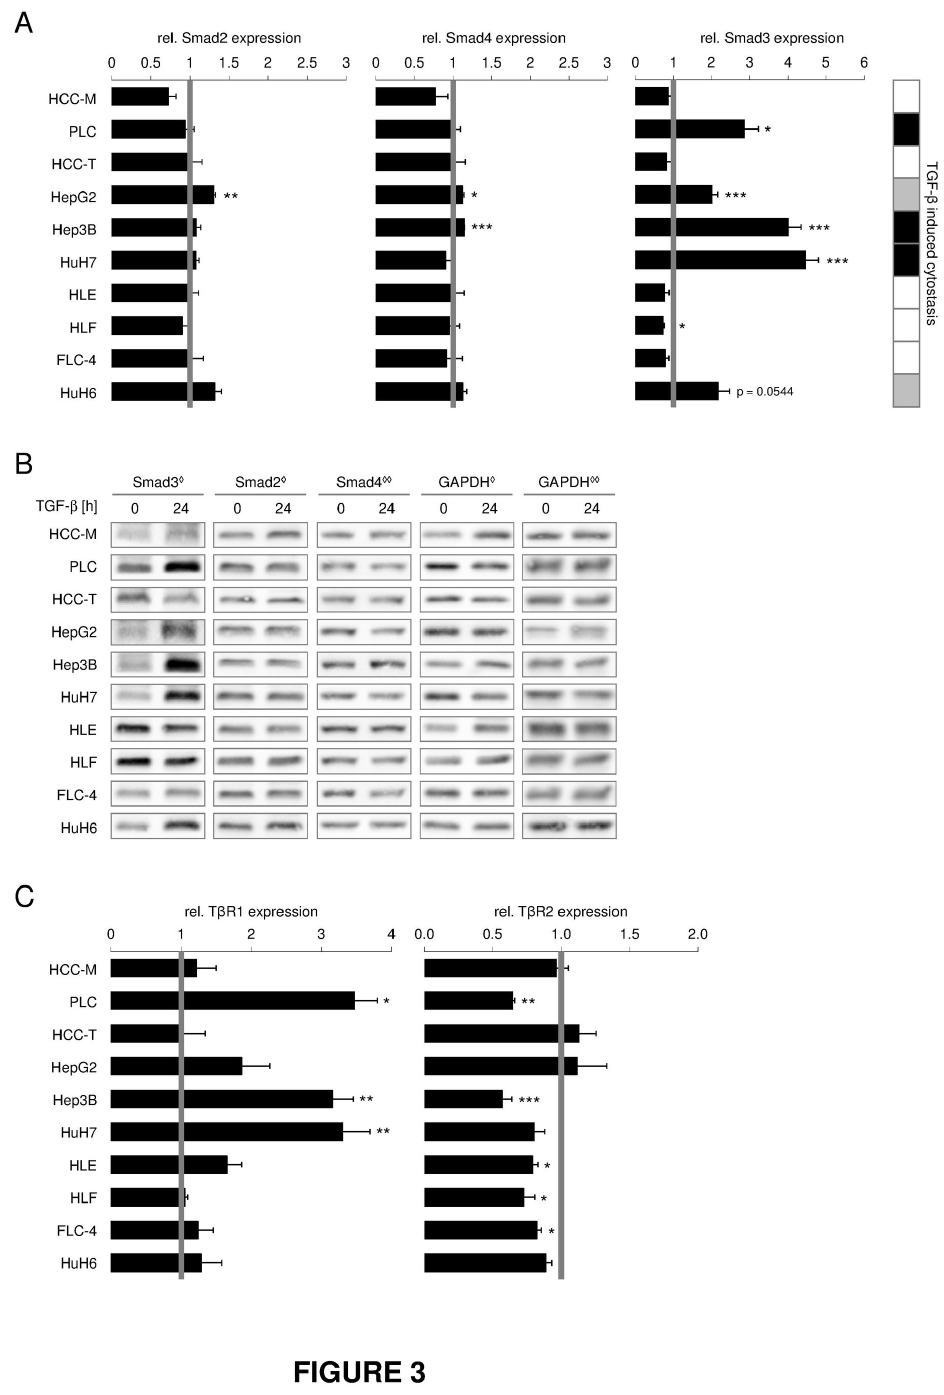
Figure 3. Induction of Smad3 and TβRI expression correlates with cytostatic responsiveness upon TGF-β treatment. Cells were cultured with or without 5 ng/ml TGF-β for 24 h. Changes in Smad2, Smad3 and Smad4 levels after TGF-β treatment were evaluated by (A) Real Time PCR and (B) Western Blot analysis using 18S rRNA or GAPDH as reference genes. ◊ and ◊ ◊ indicate which GAPDH belongs to Smad2 and Smad3 or Smad4, respectively. (C) TGF-β dependent expression levels of TGF-β Receptor I (TβRI) and II (TβRII) were detected and correlated against untreated samples using real time PCR with 18S rRNA as reference gene. Untreated samples are shown as grey lines, while filled bars display TGF-β treated samples. Significant differences are indicated as * p < 0.05, ** p < 0.01 and *** p < 0.001 (Student’s t test). doi: 10.1371/journal.pone.0072252.g003 PLOS ONE |